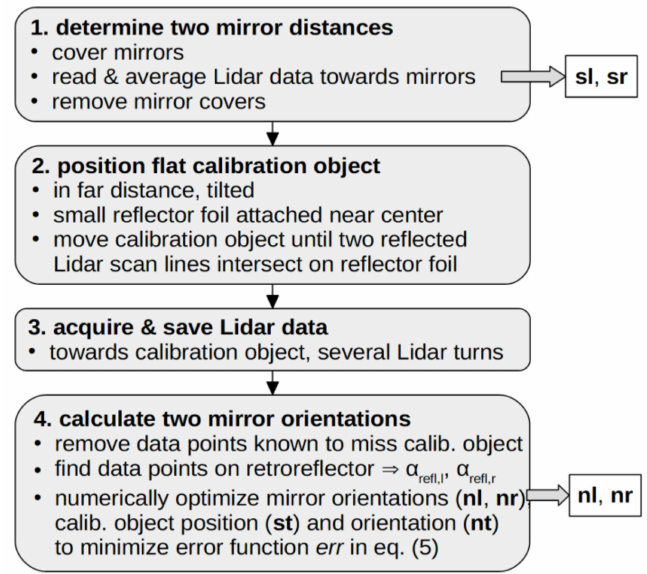
Figure 4. Flow chart of the calibration procedure. These four steps were conducted to calibrate the positions ( sl , sr ) and orientations ( nl , nr ) of the two plane mirrors next to the 2D-Lidar sensor. Details on each step are presented in Section